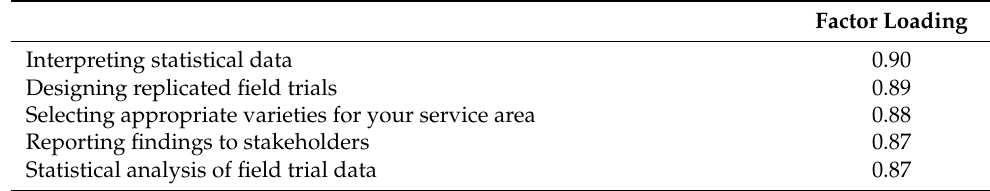
Table 19. Factor loading and items of proficiency in applied research after factor rotation.